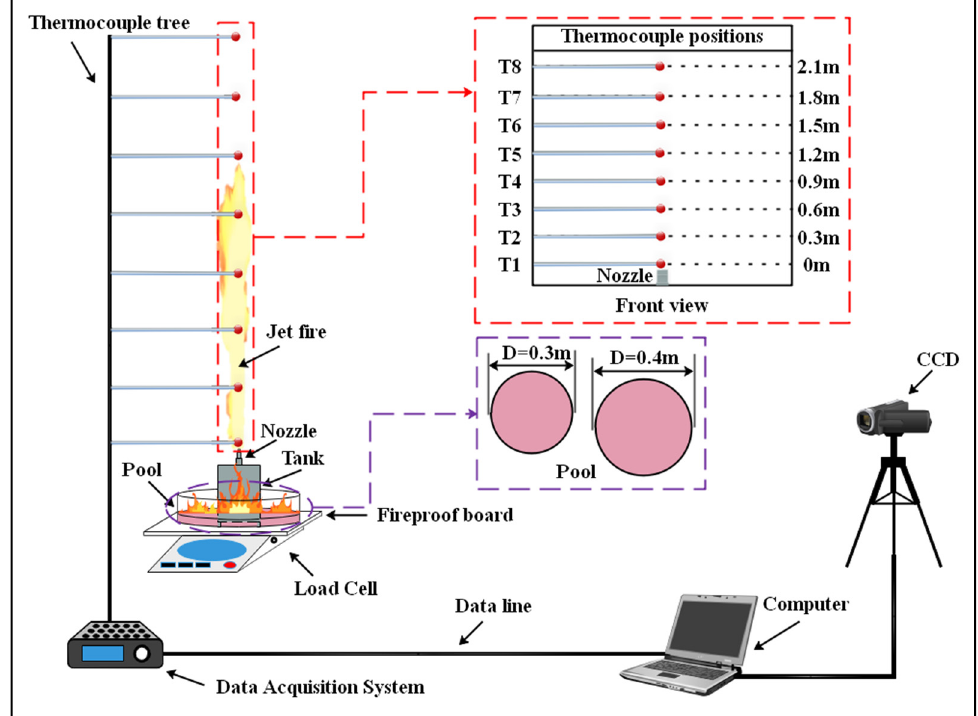
Figure 1. Schematic diagram of the experimental system. The fuel supply system consists of an oil storage tank and an oil sump. The oil storage tank is a cylindrical stainless steel tank with a 15 mm diameter circular opening at the center of the top for installation of nozzles. The bottom of the storage tank is welded with three cylindrical stainless steel brackets to ensure the direction of jet fire is vertically upward. The oil storage tank is placed in the center of the oil sump and the side wall of the oil sump is 10 cm high; the measuring system consists of a thermocouple tree composed of 8 K-type thermocouples (OMEGA) with a diameter of 1 mm (the measurement error is less than 1 °C or 3%), electronic balance (AND GP-61ks, accuracy: ±0.1 g, range: 0~60 kg) and a CCD camera (SONY NEX-FS700, pixel: 1280 × 720, frame rate: 25 fps). Among them, readings measured by the thermocouple has been corrected with the radiation loss according to the diameter of the thermocouple. The axial position of thermocouple (T1~T8) is given in Figure 1. T1 is located at 0 m above the nozzle (that is, at the nozzle), and the remaining thermocouples are evenly arranged vertically upwards along the centerline of the flame axis at 0.3 m intervals to measure the transformer oil jet fire plume axis to the centerline temperature; the thermocouple numbers are: T1, T2, T3, T4, T5, T6,